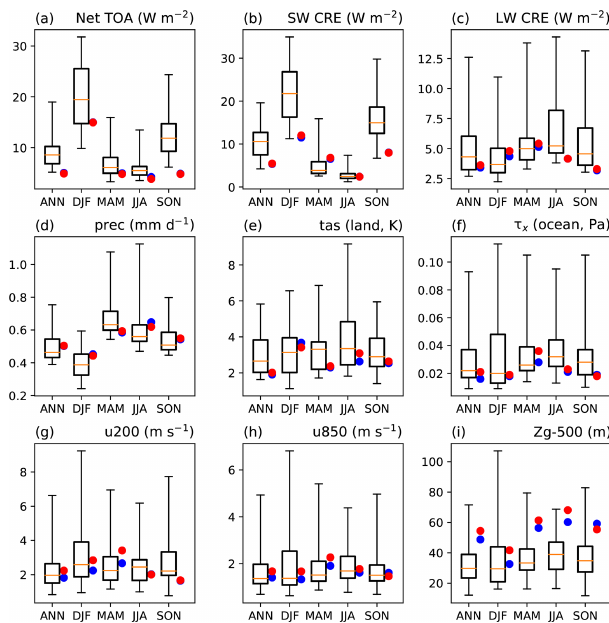
Figure 11. The same as Fig. 10 but for 50–90 ◦